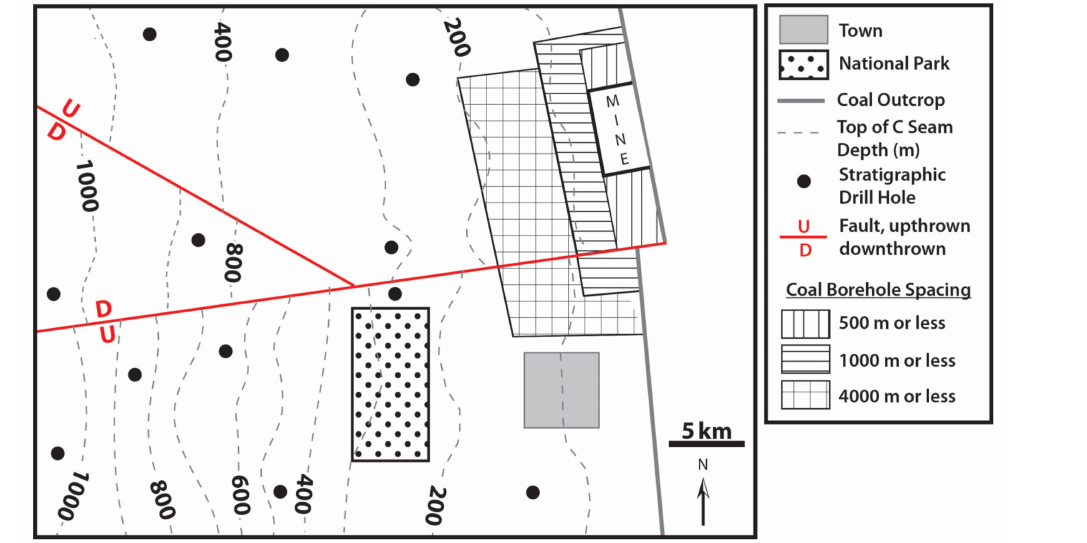
Figure 9. Hypothetical case study showing boreholes, coal seam structure, and land